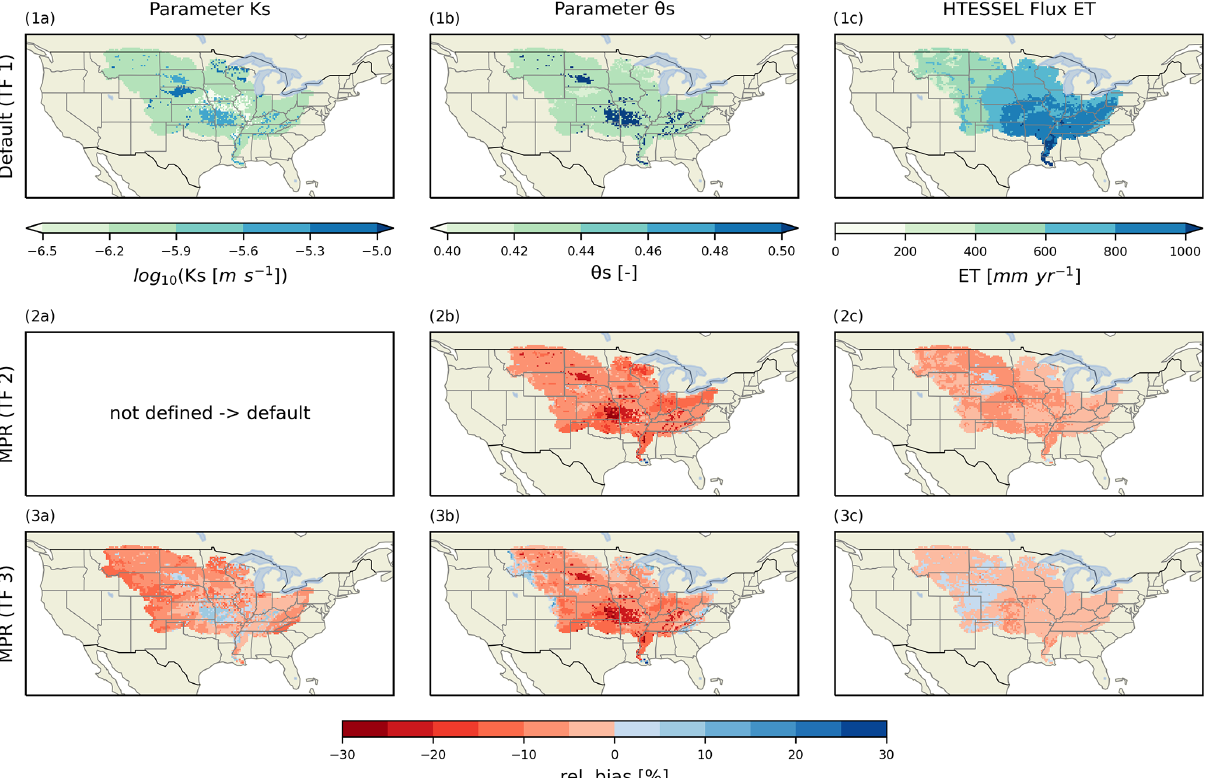
Figure 6. Maps of parameters and simulation results for HTESSEL. Columns denote the following parameters and variables: (a) soil param- eter K s (saturated hydraulic conductivity) at the soil horizon between 0.07 and 0.28m, (b) soil parameter θ s (maximum soil moisture content) at the soil horizon between 0.07 and 0.28m, and (c) mean annual evapotranspiration (ET) values of HTESSEL. Rows denote the following configurations: row (1) shows the standard HTESSEL setup using the dominant soil classes based on the SoilGrids dataset (Hengl et al., 2017) and lookup table based on the TF from (Balsamo et al., 2009), and rows (2)–(3) show the relative differences ((MPR − default) / default) of parameters and simulation results using MPR based on SoilGrids (Hengl et al., 2017) with TFs from Zacharias and Wessolek (2007) (TF2) and Wösten et al. (2001) (TF3),